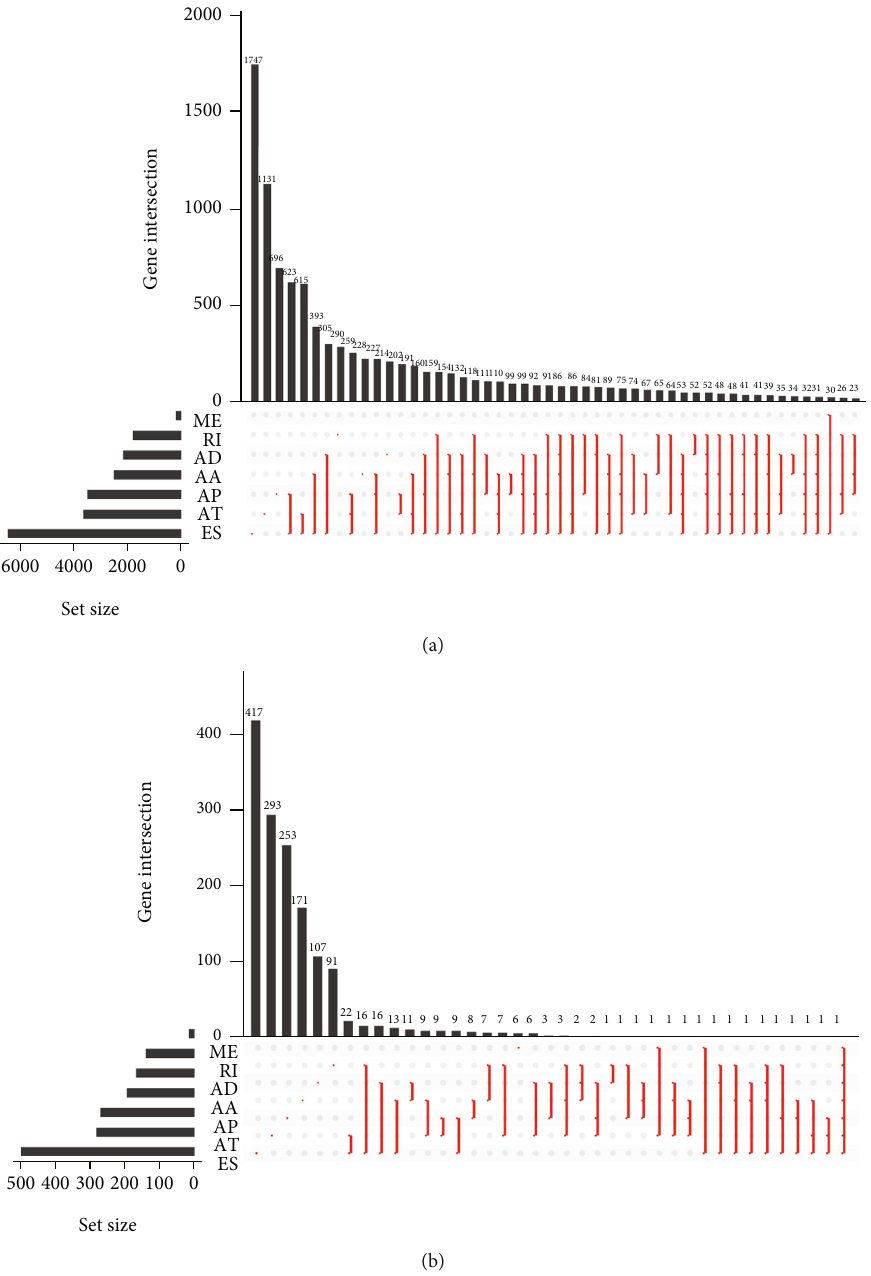
Figure 2: AS events pro fi ling in HNSCC. (a) UpSet plot of all AS events in HNSCC. (b) UpSet plot of prognosis-related AS events in